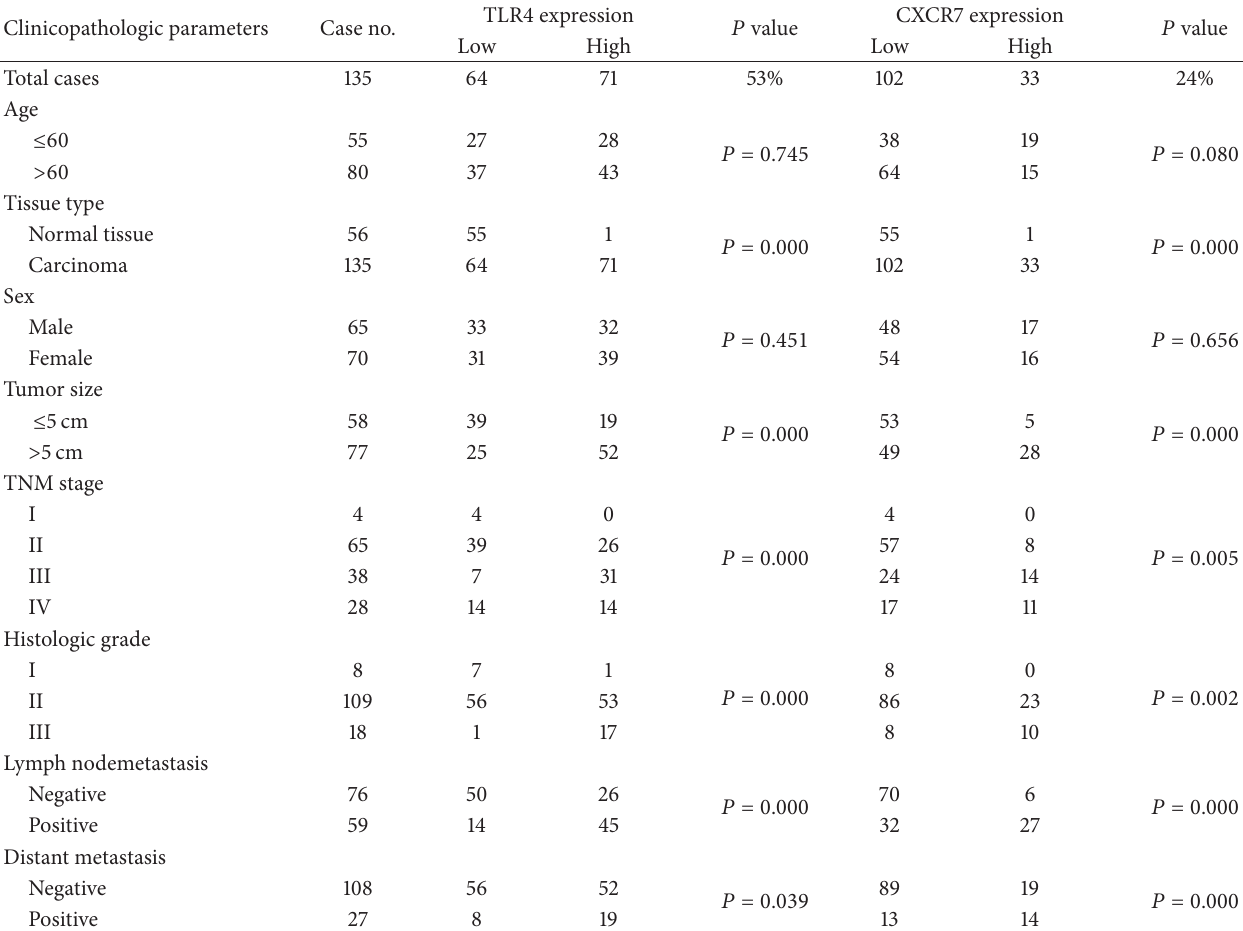
Table 1: Correlation of TLR4 and CXCR7 expression with clinicopathologic features in PTC. Clinicopathologic parameters